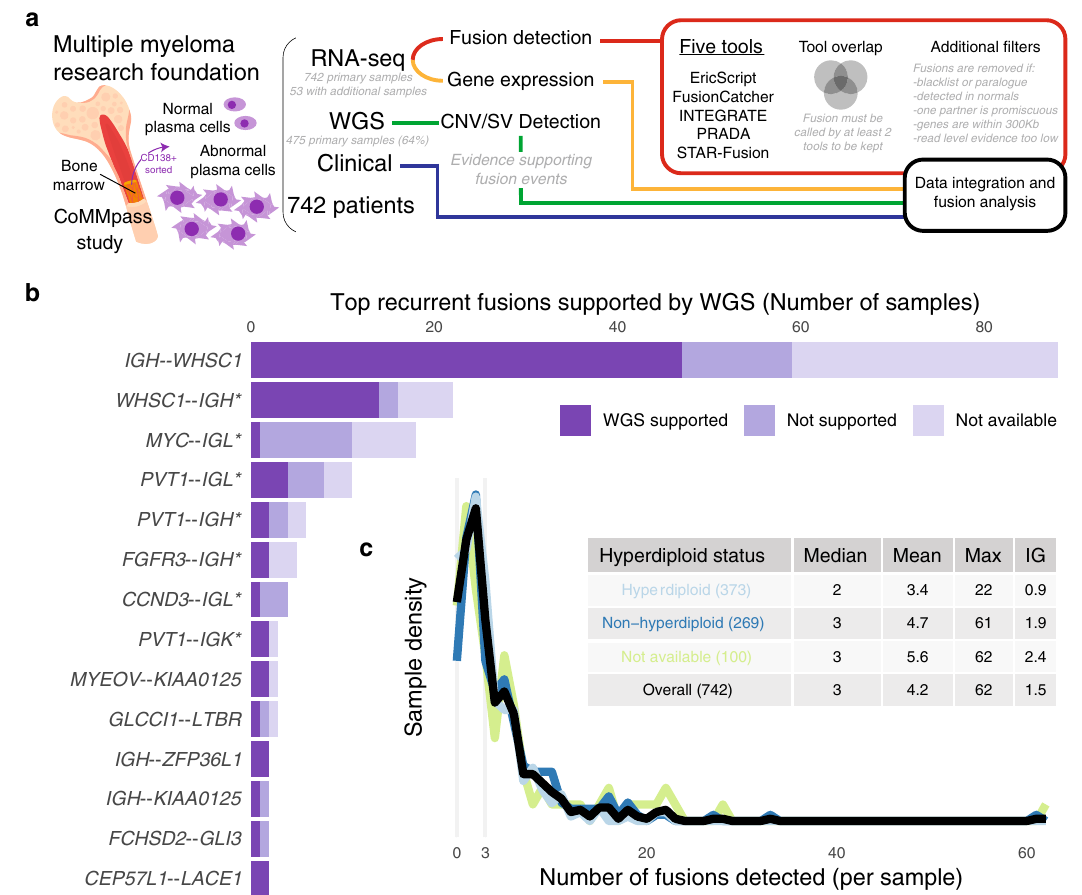
Fig. 1 Overview of pipeline and fusions reported. a Project pipeline. b Recurrent fusions with at least one sample ′ s fusion supported by WGS. An asterisk (*) annotation refers to reciprocal fusions with the opposite orientation of the canonical fusion led by an Ig partner gene. c Number of fusions detected per sample, strati fi ed by hyperdiploid status. Source data and scripts are available at https://doi.org/10.6084/m9. fi